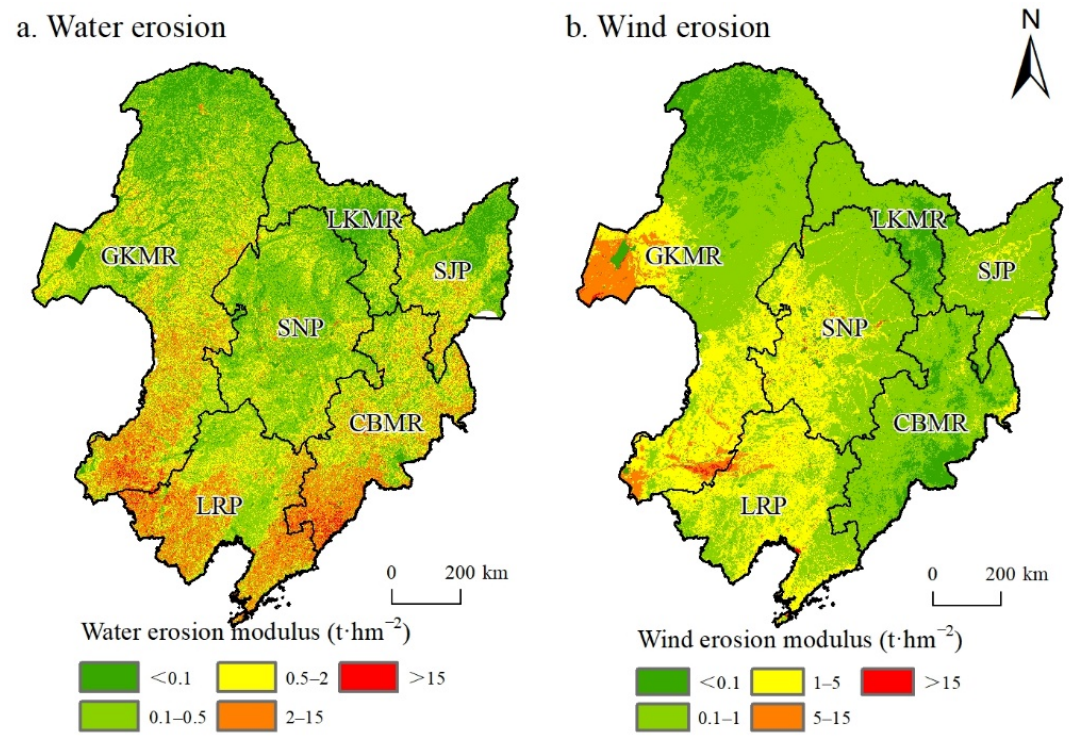
Figure 2. Distribution of multi-year mean soil erosion modulus in Northeast China from 2000 to 2020.